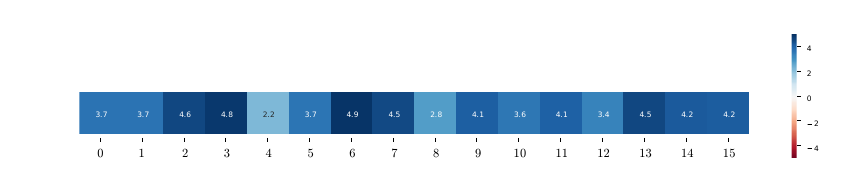
Figure 19: Average means of five experiments with random keys and 2 30 δ -sets for our five-round distinguisher with Small- AES in × σ deviations from the mean of the PRP. Each cell represents the result for the active input cell in the